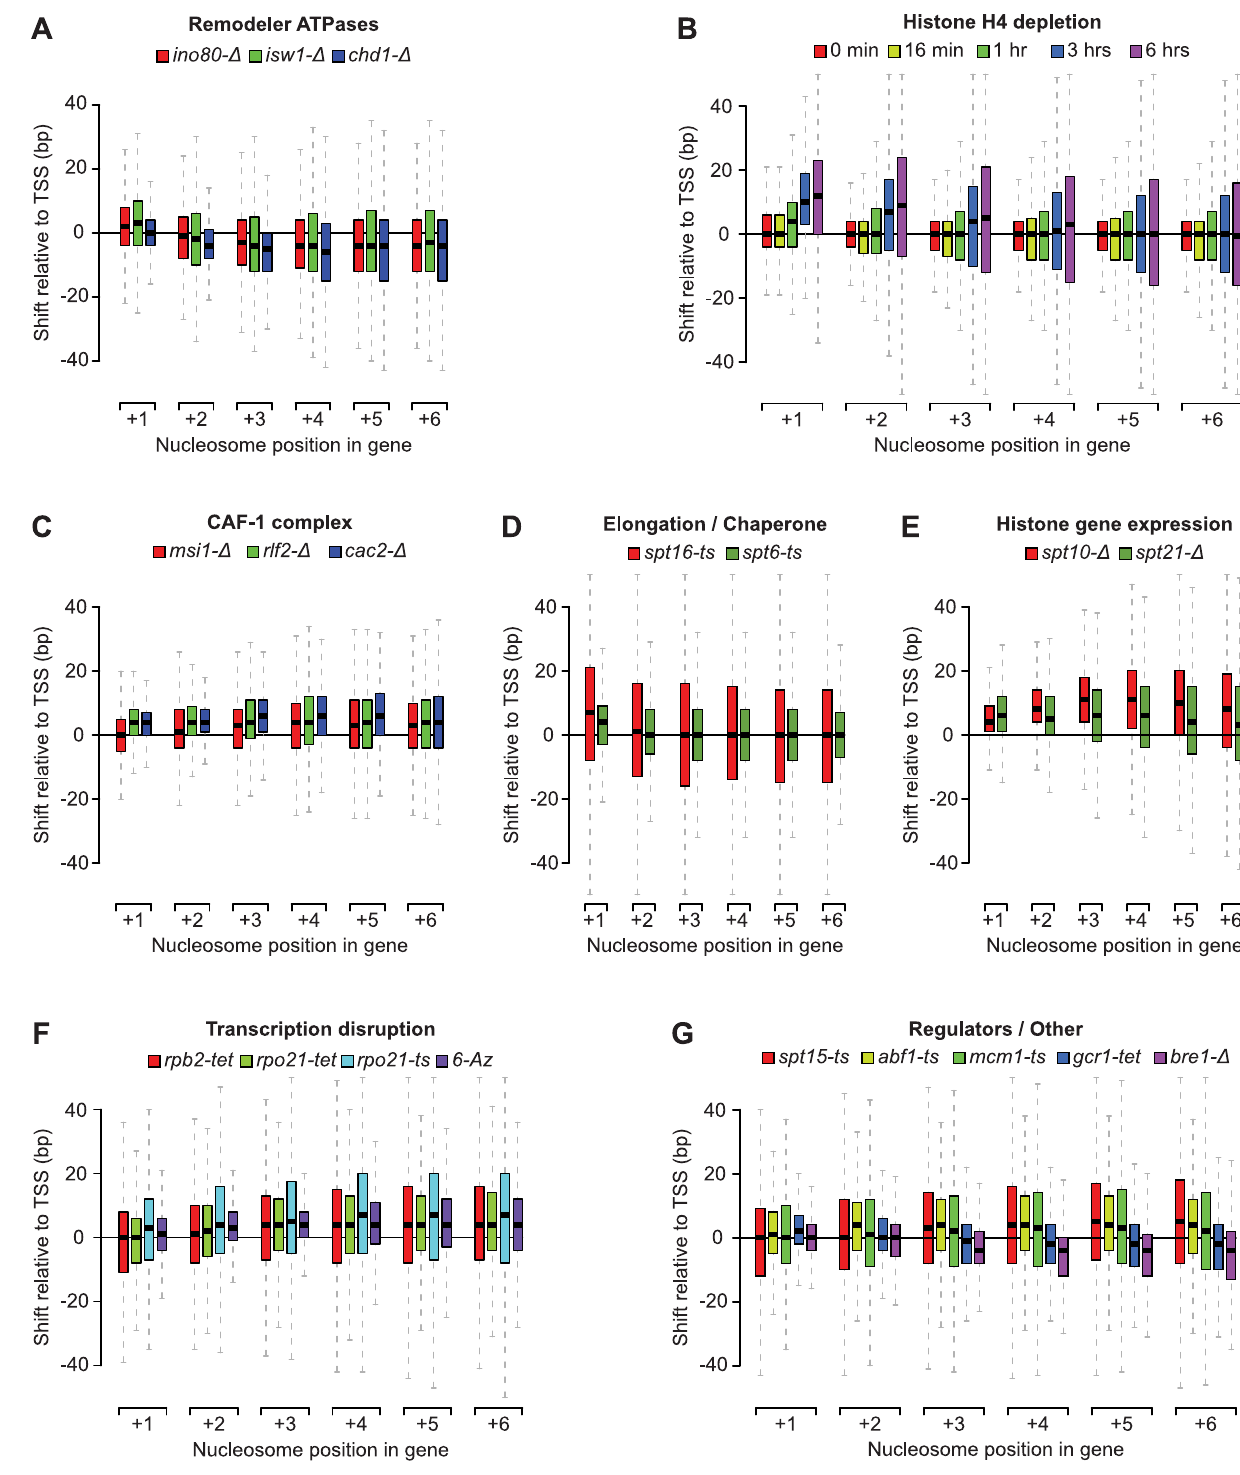
Figure 2. Profiles of genic nucleosome shifts. Box plots of nucleosome shifts for 20 conditions that show a median deviation of at least 4 base pairs for at least one genic nucleosome position, organized in 7 functional groups: A) remodeler ATPases, B) histone depletion, C) CAF-1 complex subunits, D) Elongation factors and chaperones, E) histone gene regulators, F) transcription disruption and G) all other factors. Boxes correspond to the spread between the upper and lower quartile, with medians indicated by a solid horizontal line, and whiskers extend up to 1.5 times the inter- quartile range. Nucleosome positions are relative to the transcription start site. Positive and negative numbers correspond to shifts away or towards the TSS, respectively.